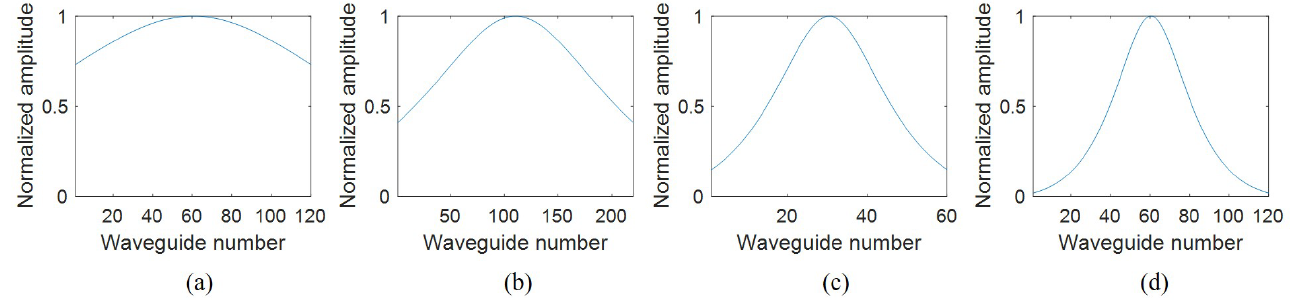
Figure 4. Normalized amplitudes at the output facets of the BBAs of ( a ) WSL1, ( b ) WSL2, ( c ) WSL3, and ( d ) WSL4.